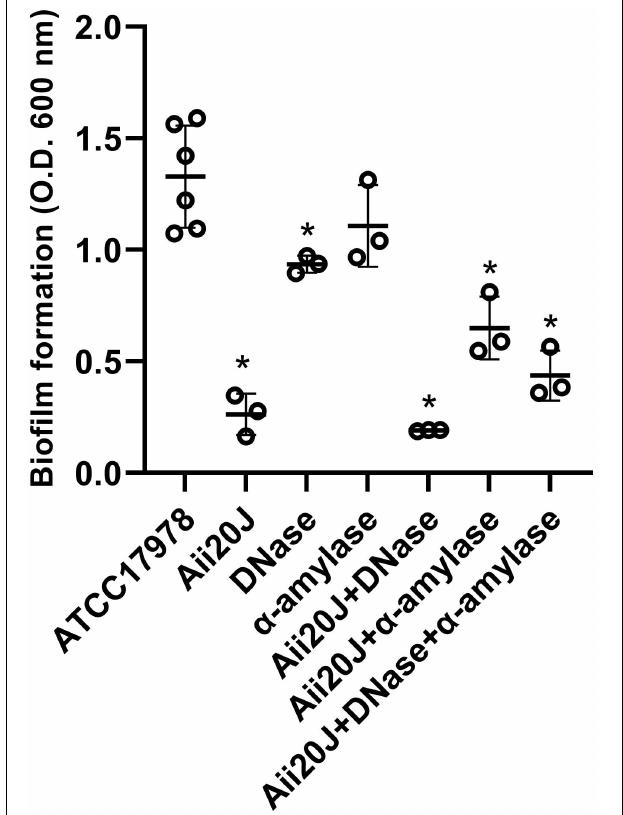
FIGURE 4 | Effect of different enzymes on biofilm formation by A. baumannii ATCC R (cid:13) 17978 TM . The QQ enzyme Aii20J (20 µ g/mL), DNase (2 U/mL), and α -amylase (10 U/mL) were added alone or in combination. Biofilms were produced in LS-LB in glass coverslips, incubated for 24 h at 37 ◦ C and stained with the crystal violet assay. The cultures were inoculated with cells from an agitated culture. Values are averages ± SD ( n = 3). Asterisks indicate statistically significant differences in comparison with the untreated control (Mann–Whitney test, p <